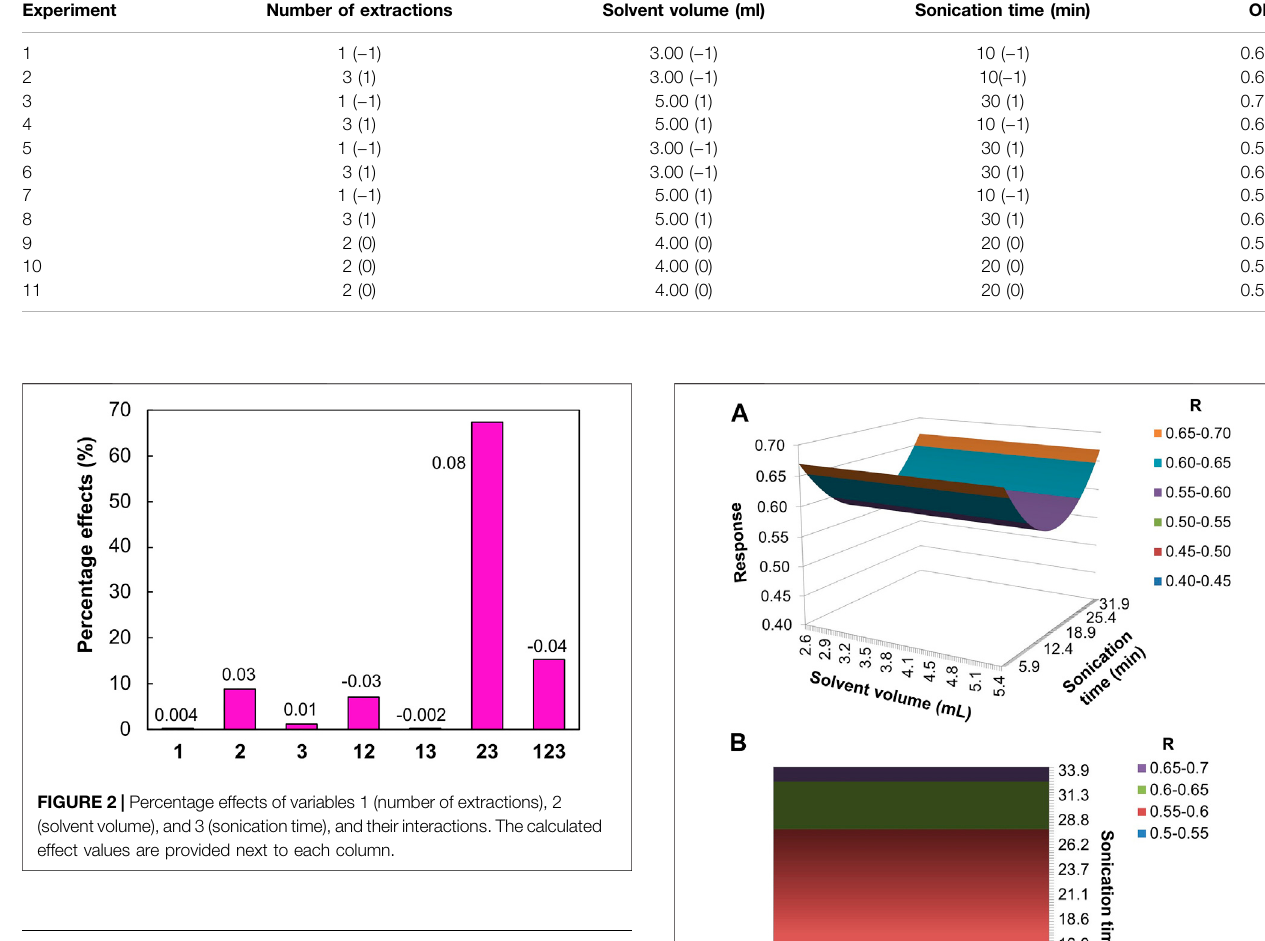
TABLE 3 | Central composite design used for the re fi nement process of the extraction conditions(solvent volume and sonication time),and theresponses in terms of overall desirability (OD). The coded values are within parentheses.